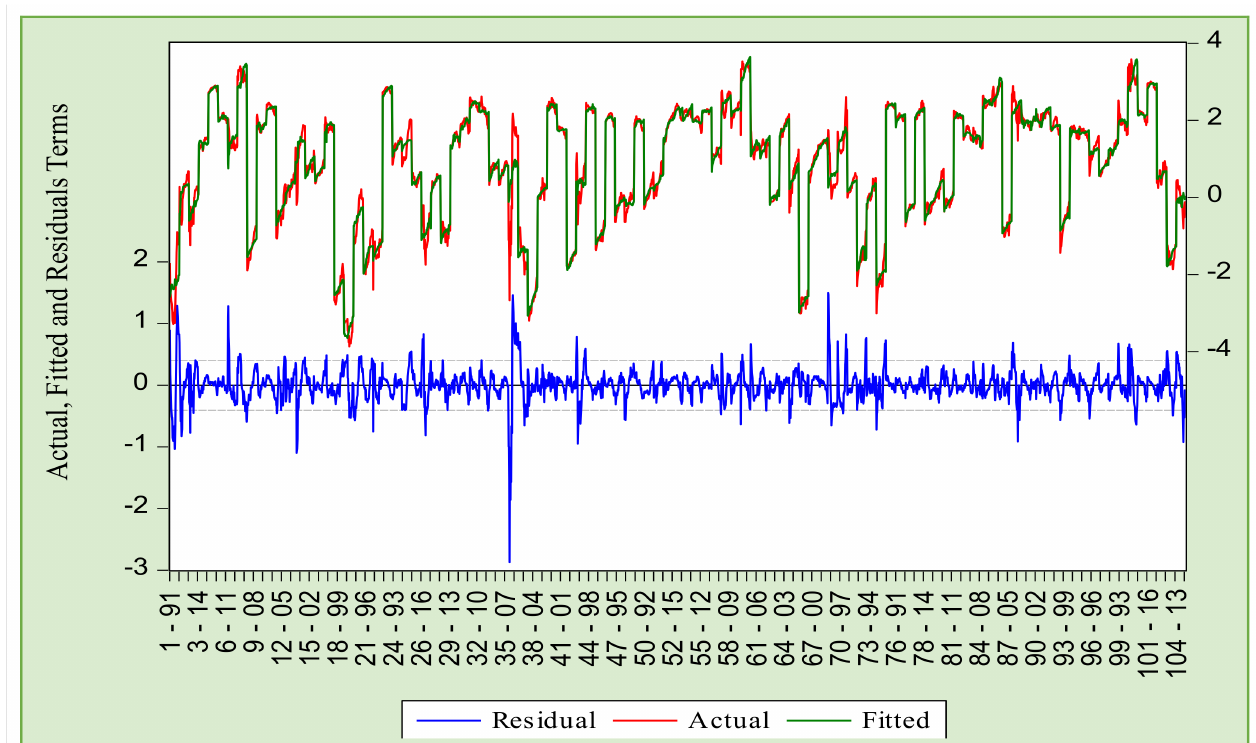
Figure 4. Actual, fitted, and estimated terms of CO 2 emissions by LCO 2 = f(LFP, LTGL, LFDI, LFD, LTRD, LURP, LLF, and LGCF).